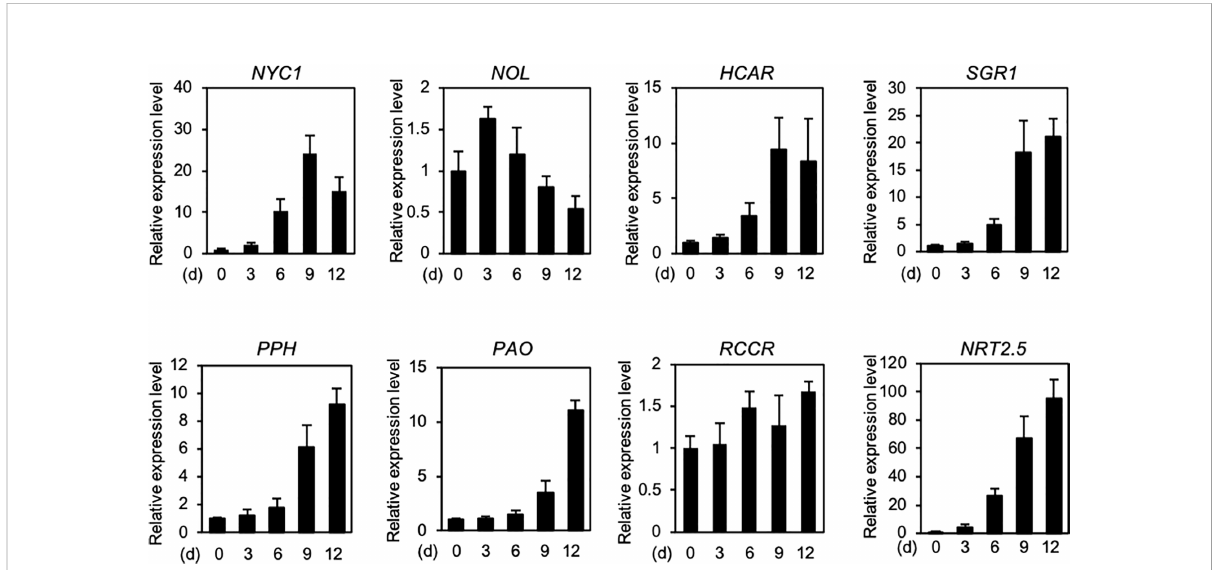
FIGURE 2 Expression pro fi les of seven genes encoding chlorophyll catabolic enzymes during N de fi ciency. Expression levels of seven chlorophyll catabolic enzyme-encoding genes NYC1 , NOL , HCAR , SGR1 , PPH , PAO , and RCCR , and a high-af fi nity nitrate transporter-encoding gene NRT2.5 (positive control) in the shoots of Arabidopsis Col-0 (wild type) seedlings are shown. Plants were grown in plates containing half-strength Murashige and Skoog (1/2 MS)-agar medium for 7 days and then under N-de fi cient conditions (0.3 mM N) for the indicated time periods. Transcript levels of each gene were normalized against the transcript levels of ACTIN2 ( ACT2 ) and then against the value obtained from samples at time zero. Data represent mean ± standard deviation (SD) of four biological